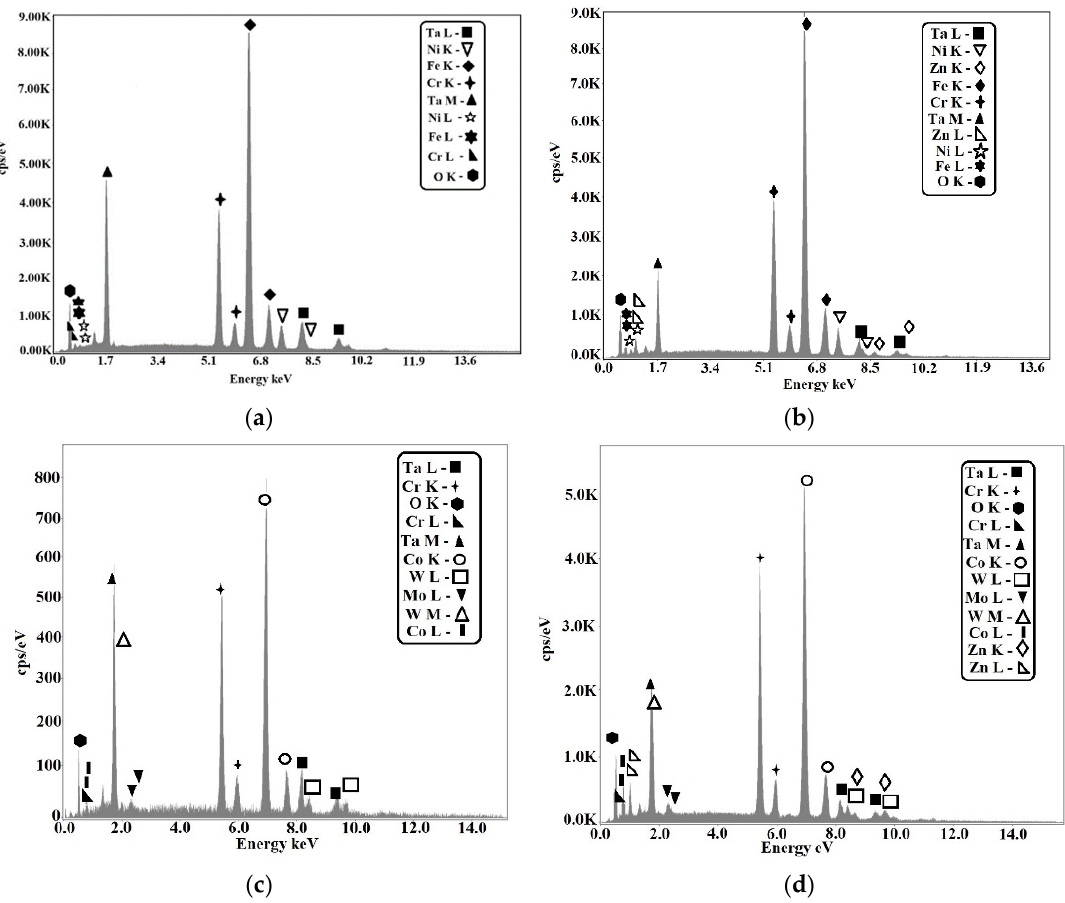
Figure 12. The EDX analysis of the samples: ( a ) S1 of cast 304L stainless steel coated with Ta 2 O 5 ; ( b ) S3 of the cast 304L stainless steel coated with 50%Ta 2 O 5 and 50%ZnO; ( c ) S2 of the Co–Cr alloy manufactured by DMLS and coated with Ta 2 O 5 ; ( d ) S4 of the Co–Cr alloy manufactured by DMLS and coated with 50%Ta 2 O 5 and 50%ZnO.